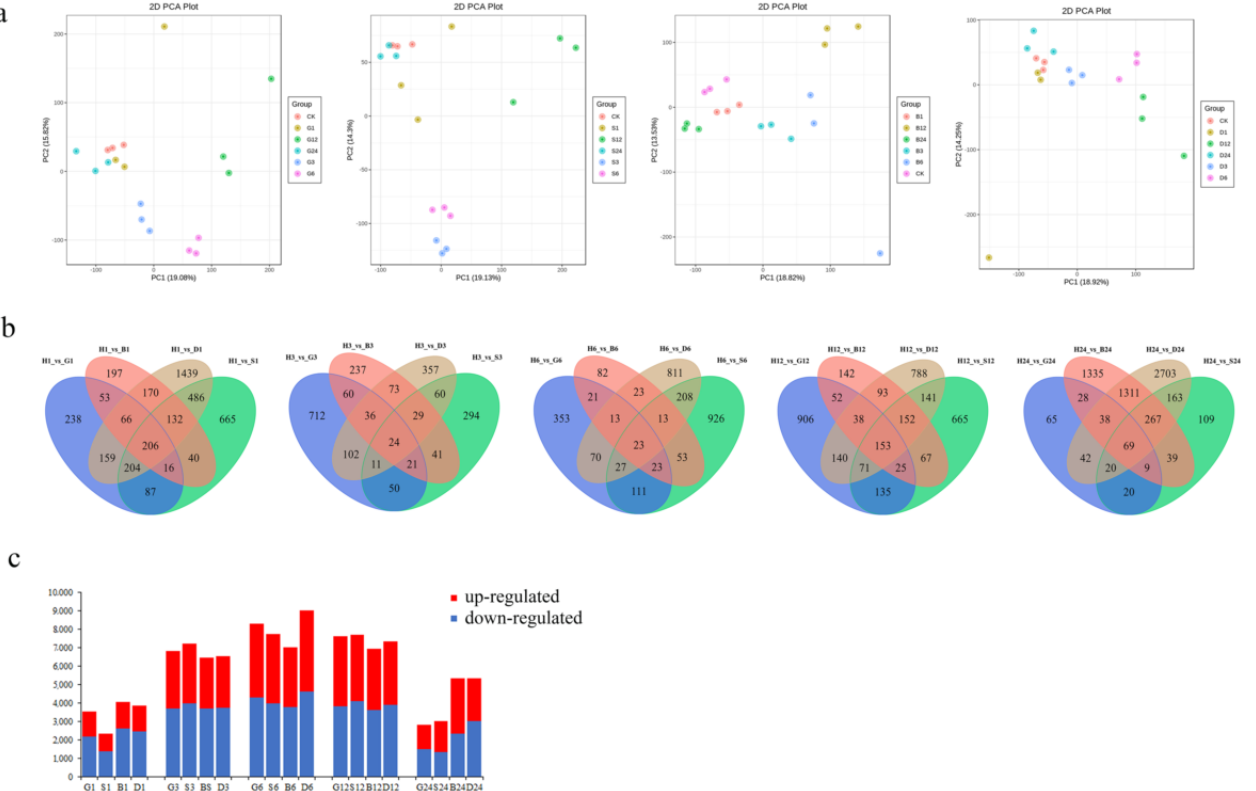
Figure 1. Transcriptomes of pakchoi under GSH treatments. ( a ) Principal component analysis (PCA) plots of transcripts identified by RNA-seq of pakchoi leaves treated with GSH, GSSG, BSO, and DTT at 1, 3, 6, 12, and 24 h. ( b ) Venn diagram illustrating the number of DEGs by GSH, GSSG, BSO, and DTT feeding over the time course. ( c ) Statistical table for the number of differential genes in different groups. Blue (down-regulated) and red (up-regulated) bars indicate differential genes ( p < 0.01).